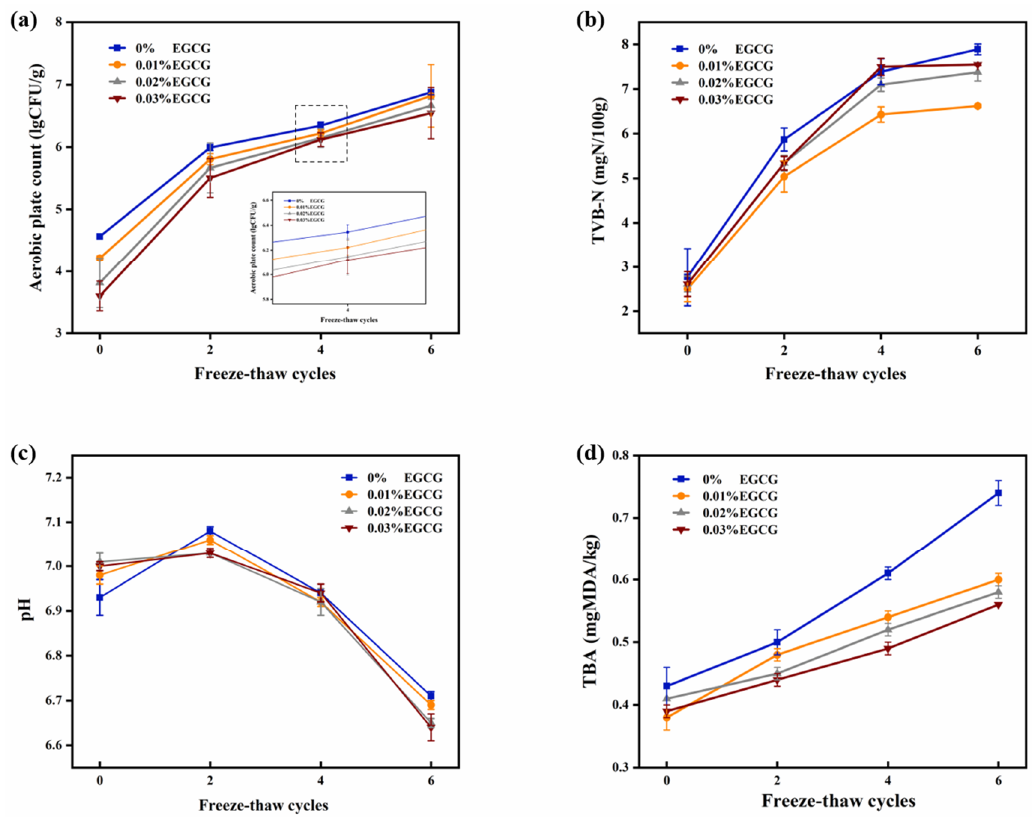
Figure 3. Changes in APC ( a ), TVB-N ( b ), pH ( c ), and TBA ( d ) of surimi gels treated with different content EGCG during F-T cycles.